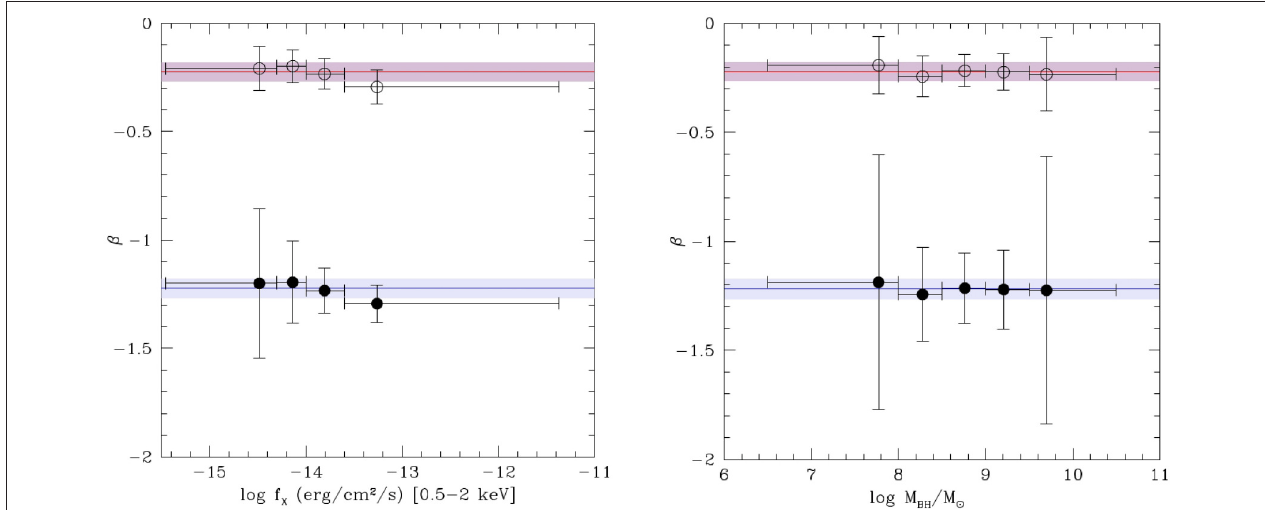
FIGURE 3 | The dependence of β xy and β bis in bins of soft X-ray flux (Left panel) and black hole mass (Right panel) . No dependence is found, and all the values of β xy (empty circles) and β bis (filled circles) are compatible with the corresponding ensemble values β xy = − 0.22 ± 0.04 and β bis = − 1.22 ± 0.05, which are indicated respectively by the red and blue lines, and by the lighter bands for the uncertainties. The horizontal bars indicate bin widths, not errors.